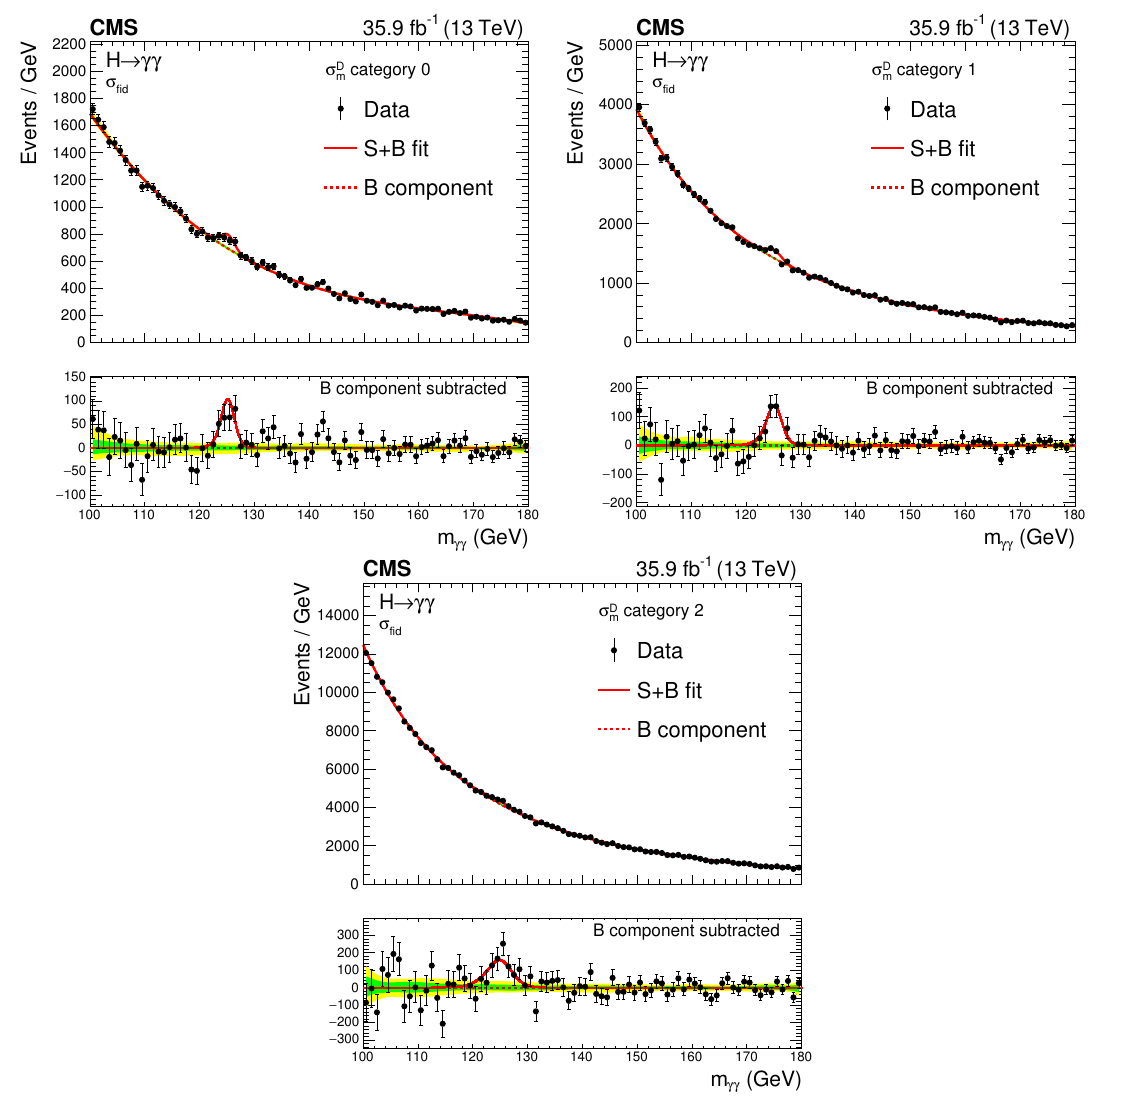
Figure 2 . The diphoton mass spectrum in data (black points), together with the best signal-plus- background (cid:12)t (red lines), for each (cid:27) D category employed for the measurement of the inclusive m (cid:12)ducial cross section, as de(cid:12)ned in section 7. The two bands indicate the one and two standard deviation uncertainty in the background